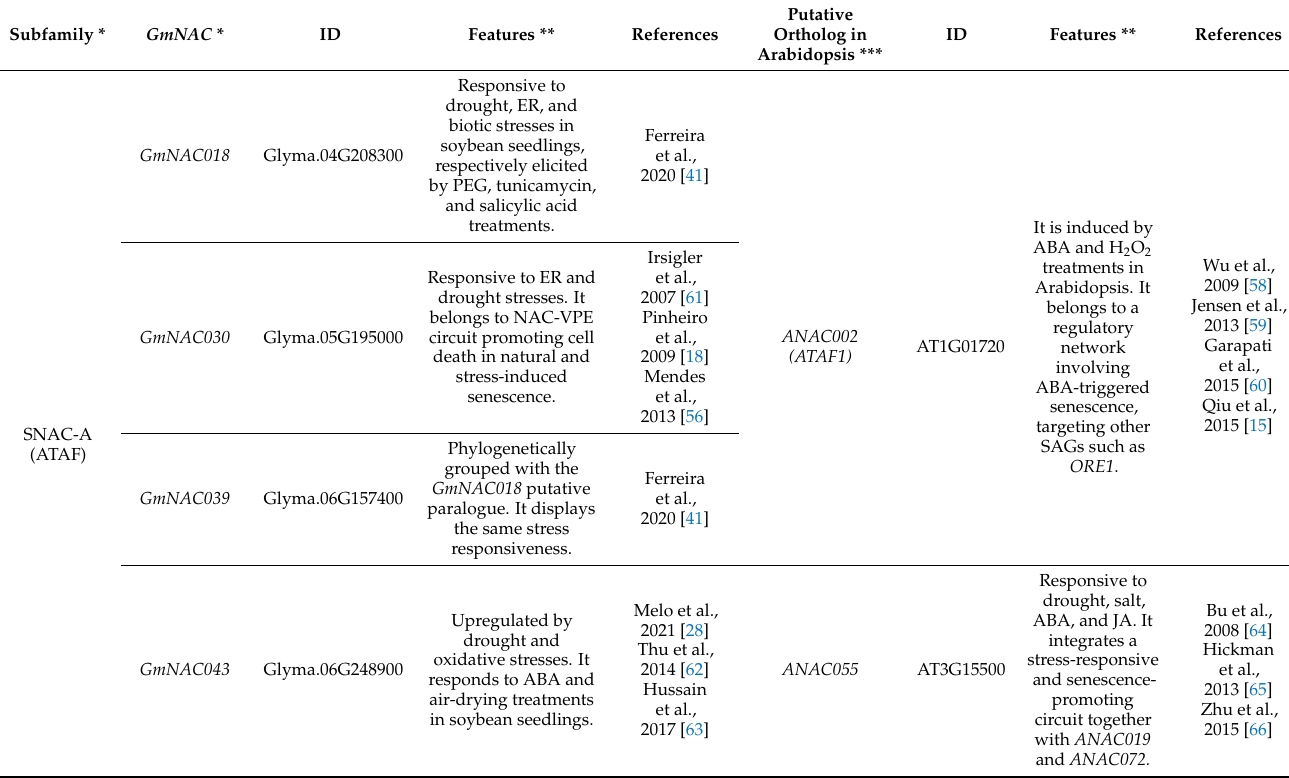
Table 1. GmNAC-SAGs and their putative AtNAC-SAG orthologs are responsive to multiple